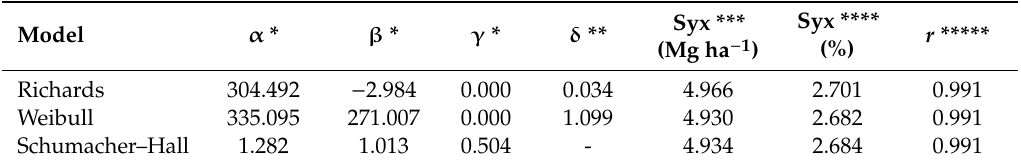
Table 5. Statistical parameters of the non-linear models obtained by adjusting the total biomass in the eucalypt